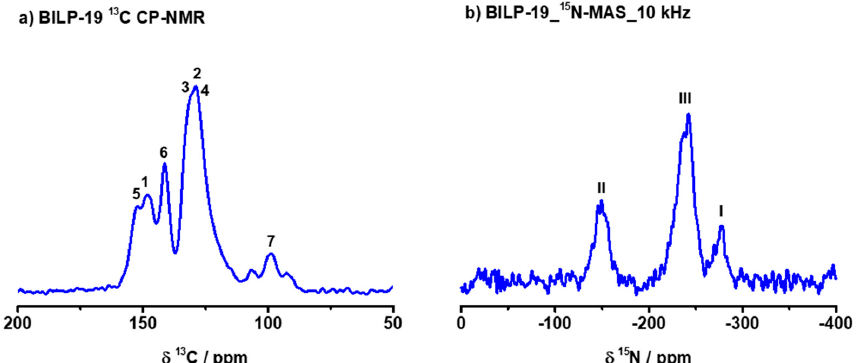
Figure 1. 13 C CP NMR ( a ) and 15 N MAS NMR ( b ) spectra of BILP-19 with assignment of the